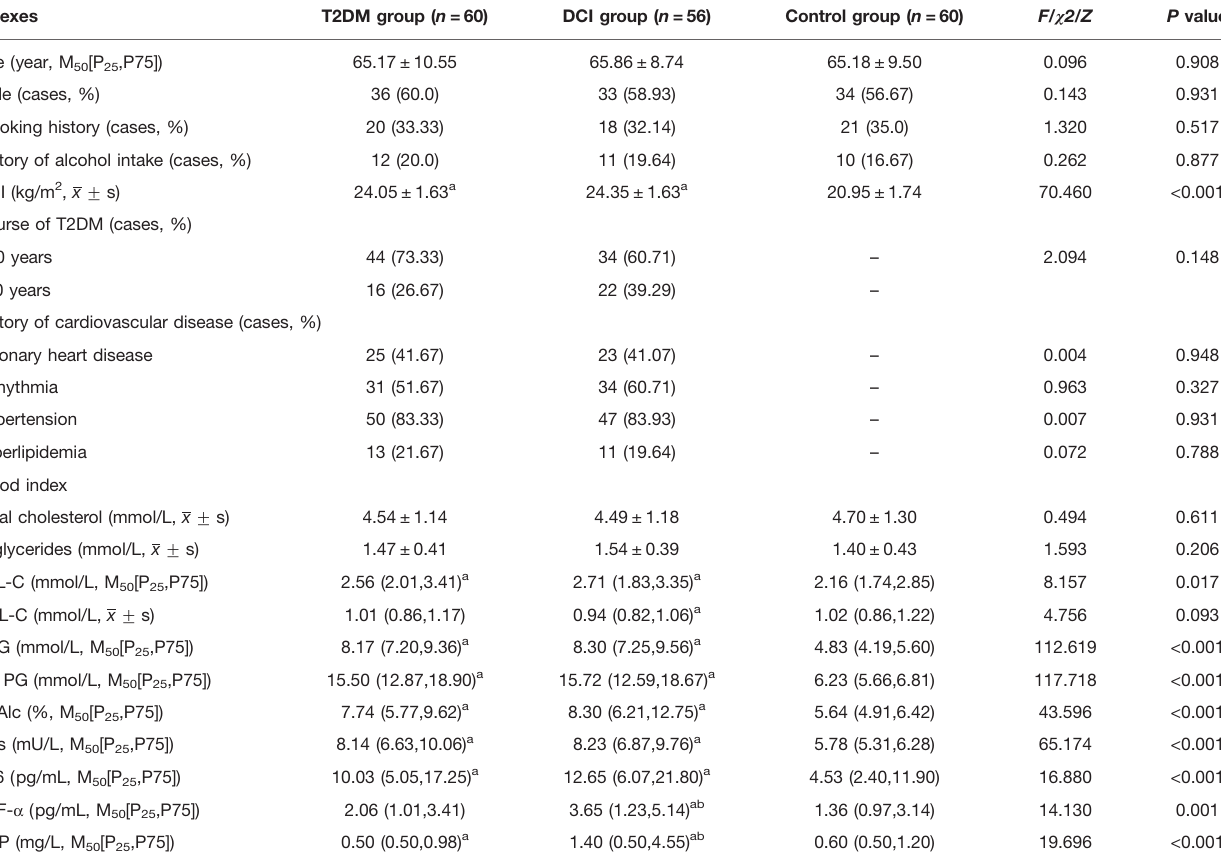
TABLE 1 | Comparison of clinical data in three groups x +